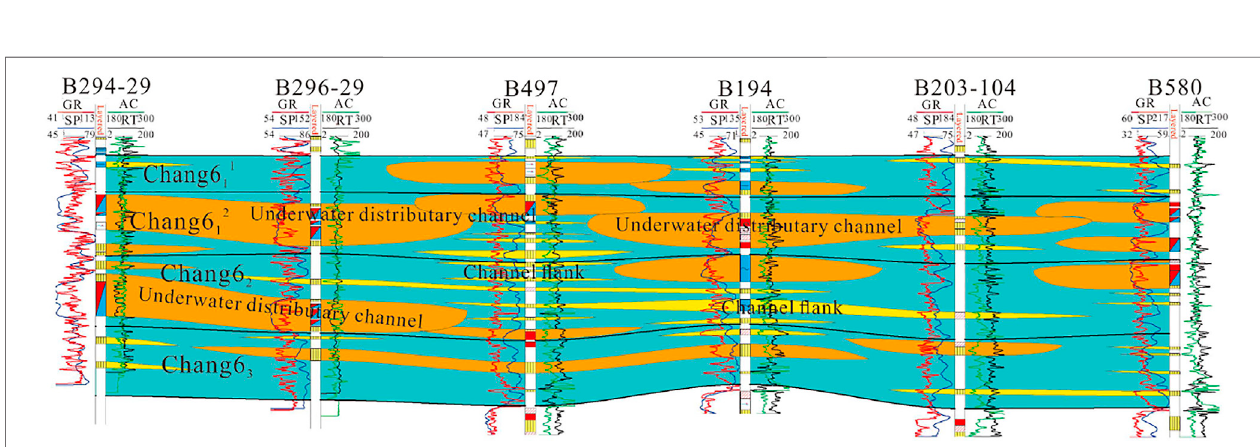
FIGURE 3 | Pro fi le of sedimentary microfacies in the Chang6 Member in the study area (SW-NE direction).